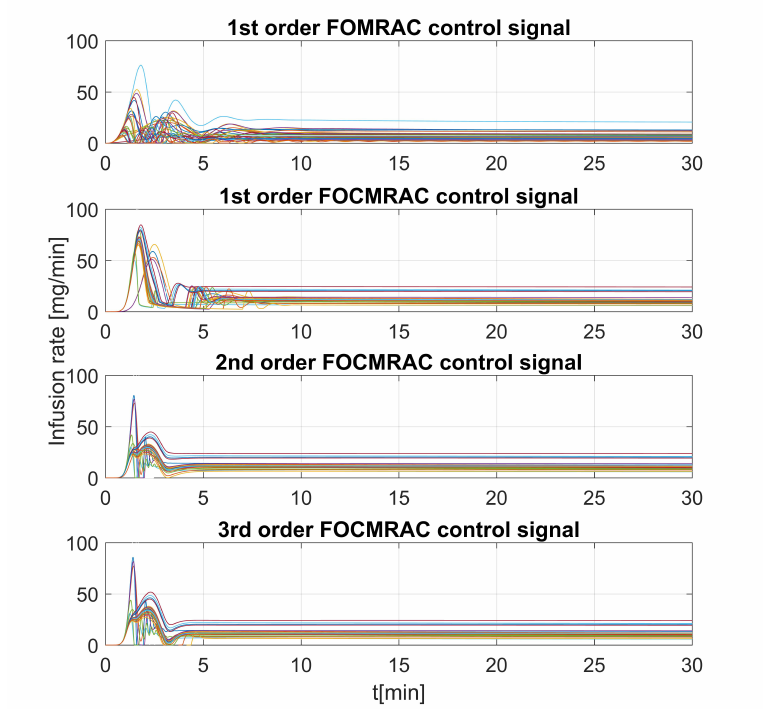
Figure 10. Control input of the FOMRAC and FOCMRAC schemes with the 30 virtual patients.